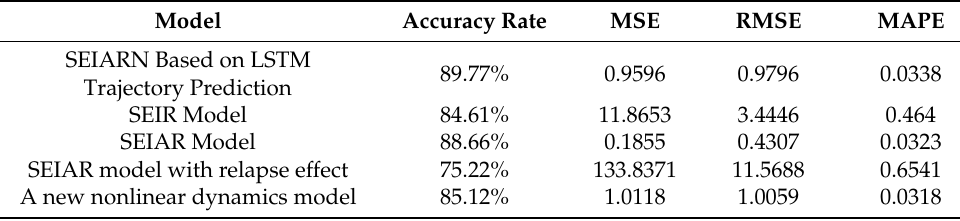
Table 8. Model prediction results of death toll.